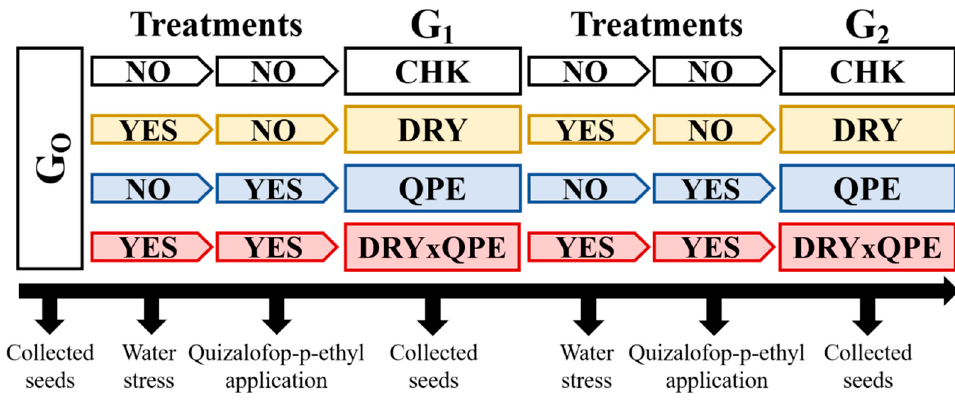
Figure 1. Design of CHK (no stress), DRY (drought), QPE (quizalofop-p-ethyl), and DRY × QPE (drought followed by quizalofop-p-ethyl) populations in two generations (G 1 and G 2 ) from this G 0 Eragrostis plana plants.